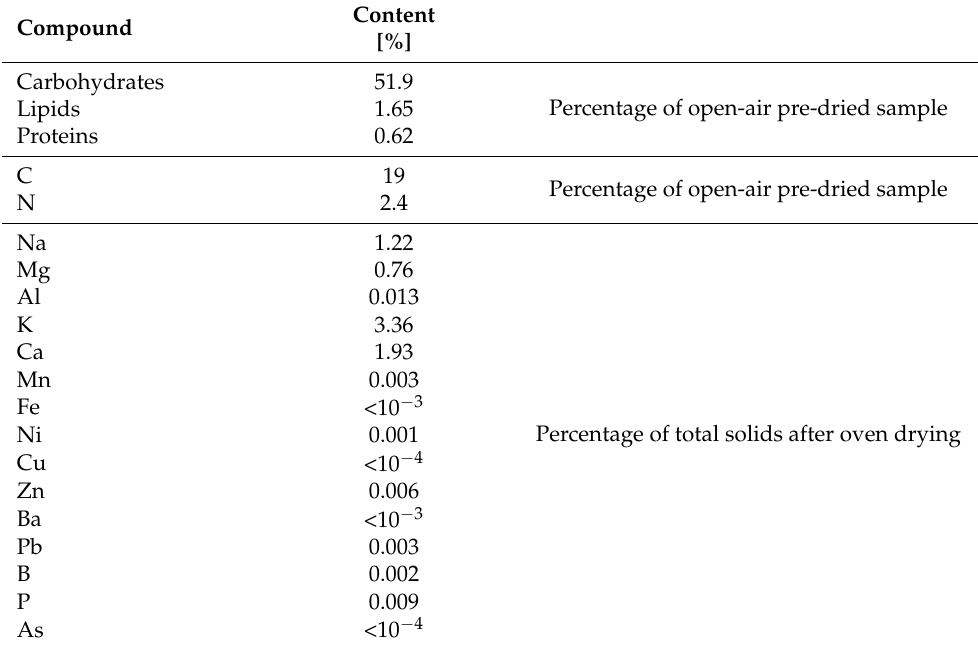
Table 2. Proximate and elemental analysis of Sargassum